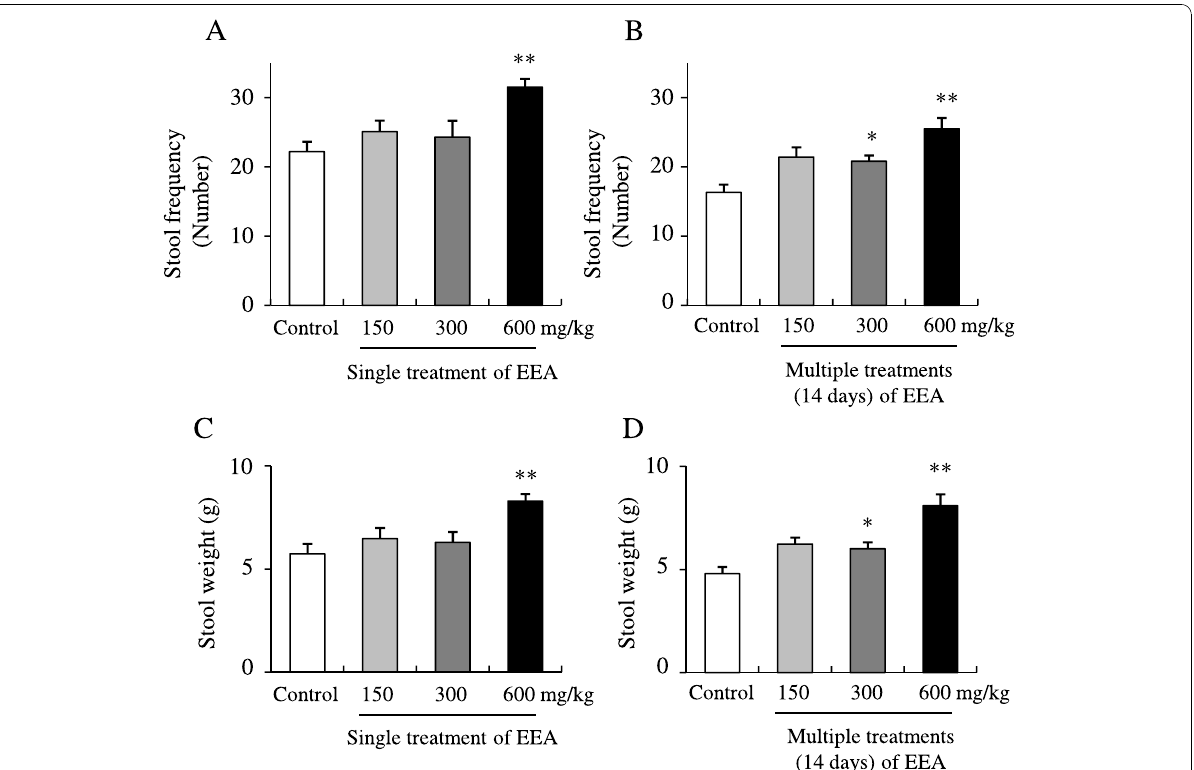
Figure 2 Laxative effects of single (A and C) and 14-day (B and D) administration of EEA on normal rats . Data are shown as the mean ± S.E.M., n = 12, *p < 0.05, **p < 0.01 vs. control (one-way ANOVA and Tukey ’ s multiple comparison